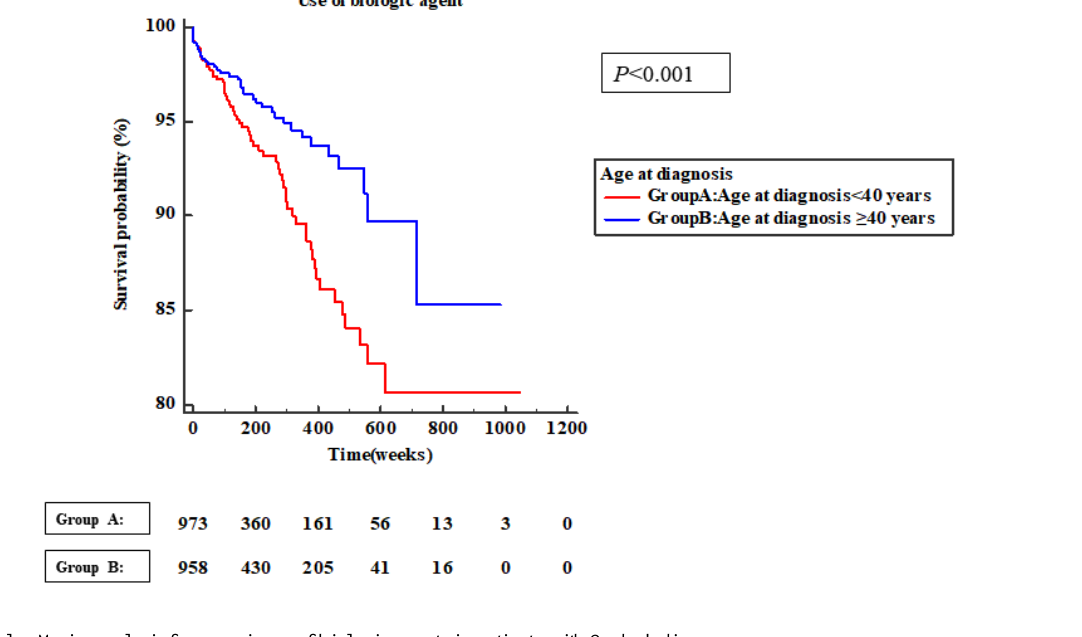
Figure 3. Kaplan-Meier analysis for experience of biologic agents in patients with Crohn's